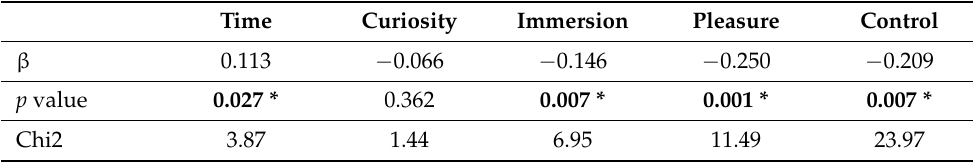
Table 6. Effect of perceived cognitive effort on each cognitive absorption (CA) dimension.